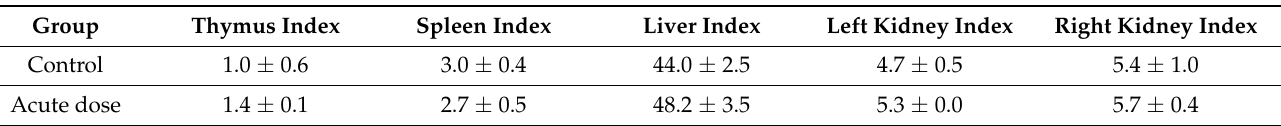
Table 6. Effect of administrating a dose of 2000 mg/Kg body weight of nutraceutical on the organ weight index (mg/g) in mice—acute toxicity testing.